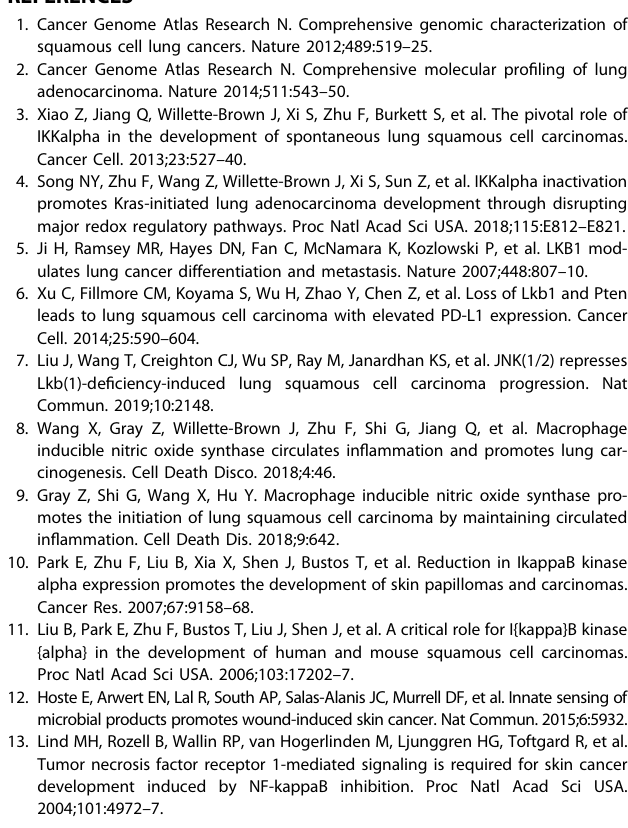
Fig. 5 The mechanism for regulation of UBE2C expression. a Immunoblotting showing levels of the indicated nuclear and cytoplasmic protein levels in KAL LU + and KAL LU- cells following TNF (10 ng/mL) stimulation. α -Tubulin, a cytosol protein-loading control. b Survival curves of human lung SCC expressing double-high TNFRSF1A and REL levels compared to low TNFRSF1A and REL levels. These data were obtained from the Kaplan – Meier plotter. c Immunoblotting showing UBCH10, E-cadherin, and keratin 5 (K5) levels in KAL LU + cells treated with and without TNF (10 ng/mL) treatment for 60 min. β -actin, a protein-loading control. d RT-PCR shows UBCH10 expression in KAL LU + cells treated with TNF (10 ng/mL). Mean ± SEM (three repeats per group). ** P < 0.01; Student ’ s t -test. e Immunoblotting showing levels of the indicated protein levels in KAL LU + cells following treatment with three different si-UBE2C RNAs (A, B, C, and A + B + C). β -actin, a protein-loading control. f ChIP assay showing the enrichment of p65, c-Rel, and IKK α associated with the Ube2c promoter (p) on regions upstream of − 500 bp